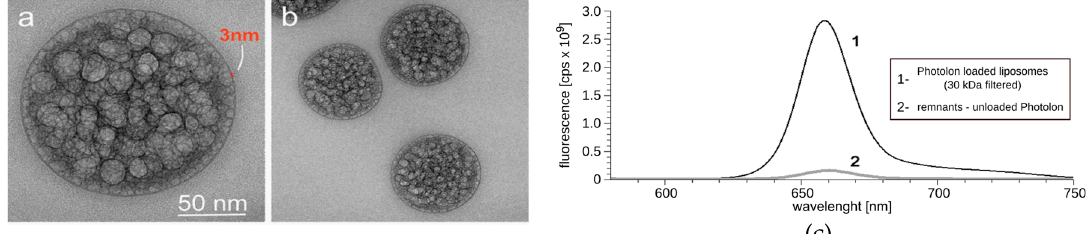
Figure 1. Transmission electron micrographs of liposomal formulation of Photolon of ( a ) a single liposome with a spherical bilayer of 3 nm of thickness and ( b ) separate, uniform liposomes packed with photosensitizer. ( c ) Fluorescence 30 kDa filtered liposomes, along with fluorescence of supernatant indicating high encapsulation efficiency.